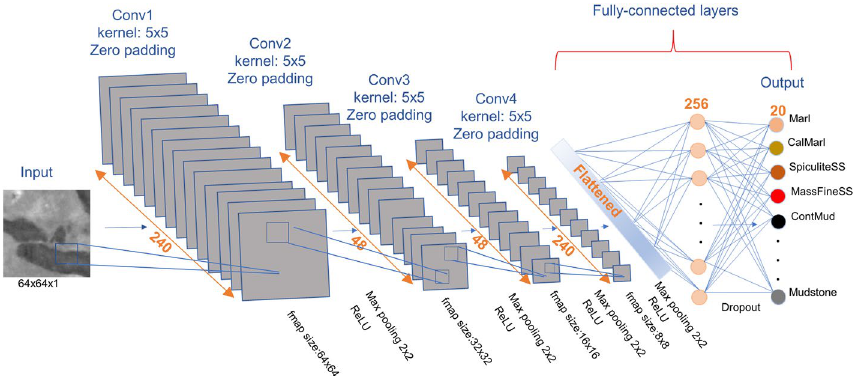
Fig. 7 Proposed CNN architec- ture for lithofacies classifica-